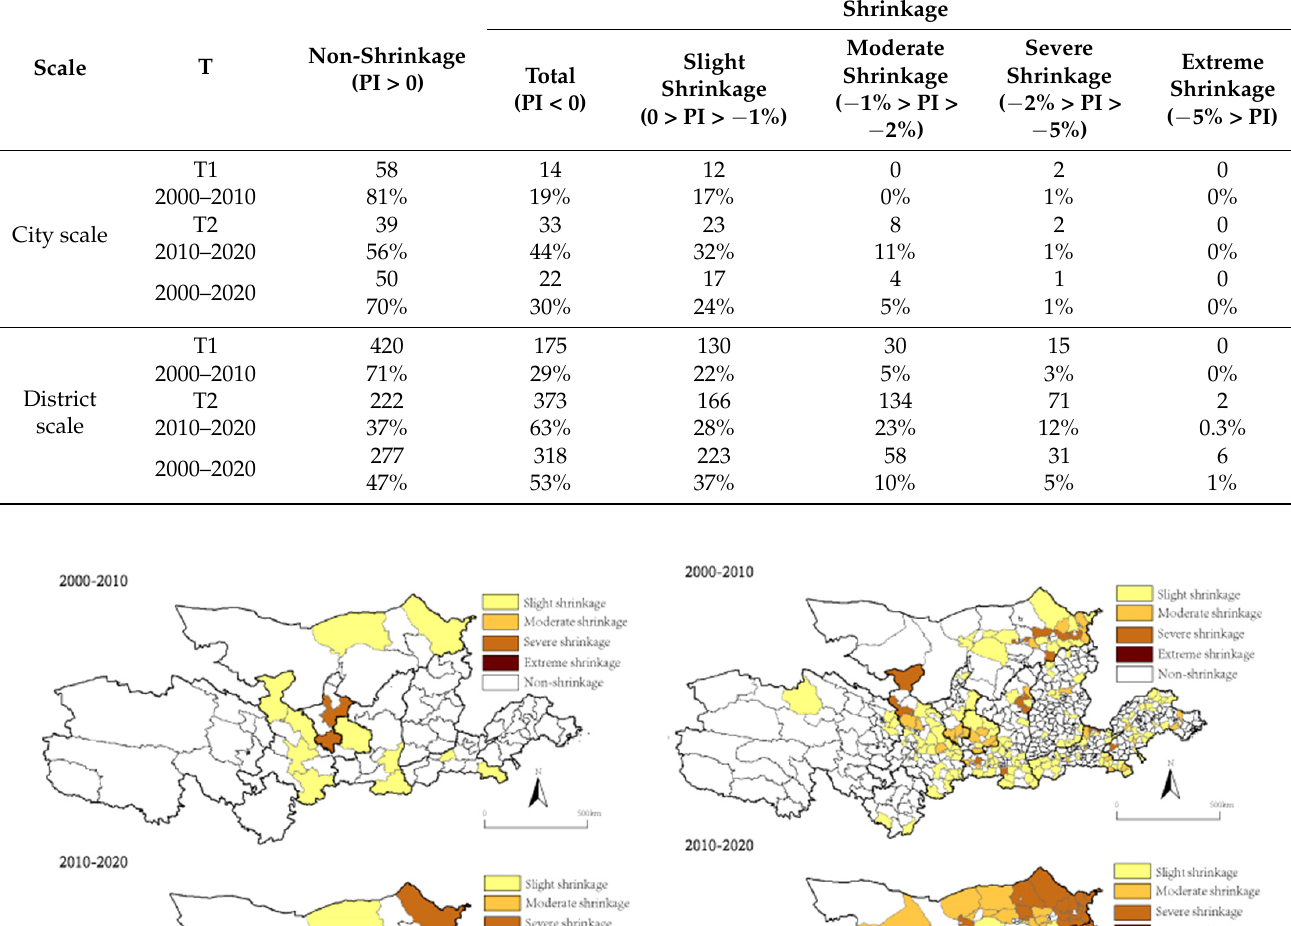
Table 2. Shrinkage numbers during different time spans in Yellow River Basin under the popula- tion dimension.